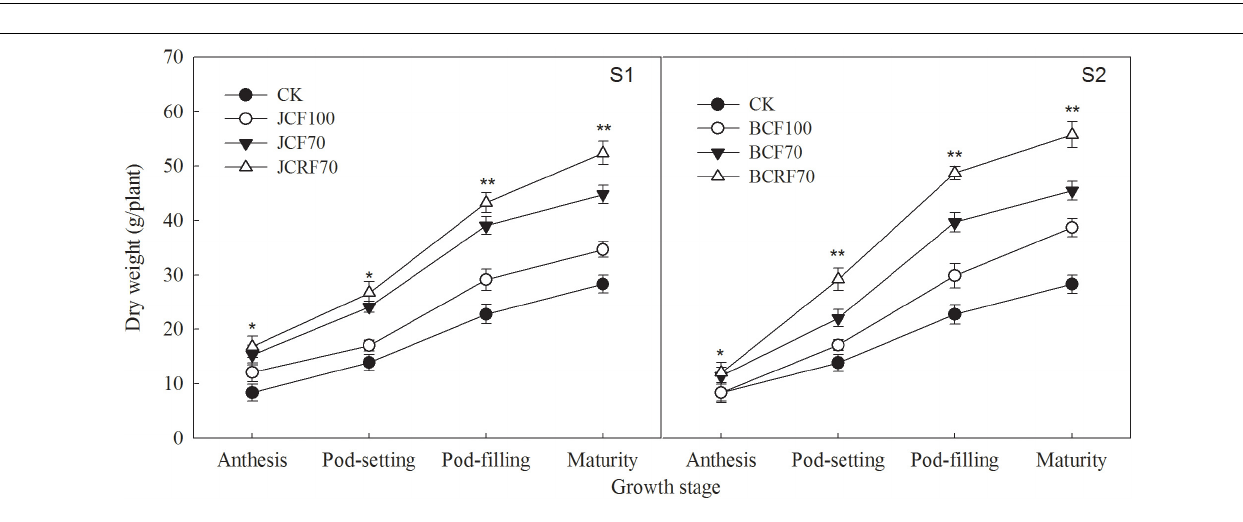
FIGURE 5 | Effect of different N fertilizer management regimes on dry matter accumulation in peanut. Abbreviations as in Figure 2 . Means and standard errors based on three replicates are shown. NS, not significant; ∗ significant at the 0.05 probability level; ∗∗ significant at the 0.01 probability